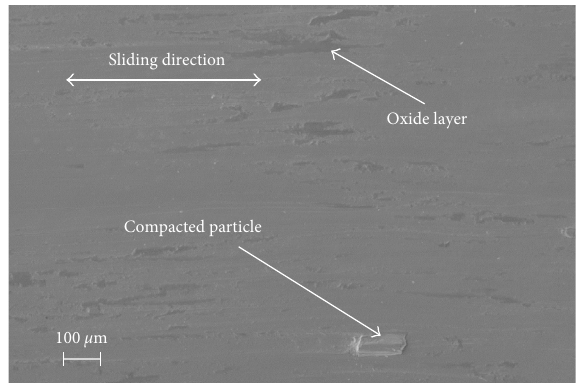
Figure 16: Scanning electron microscope micrograph of the steel 2 disk surface tested at 200 °